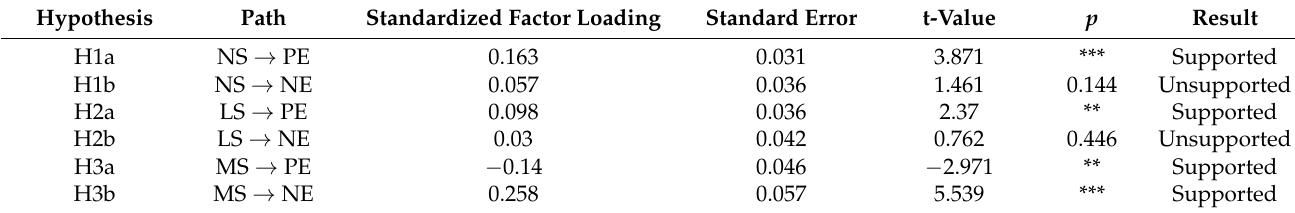
Table 7. Hypotheses testing using the modified